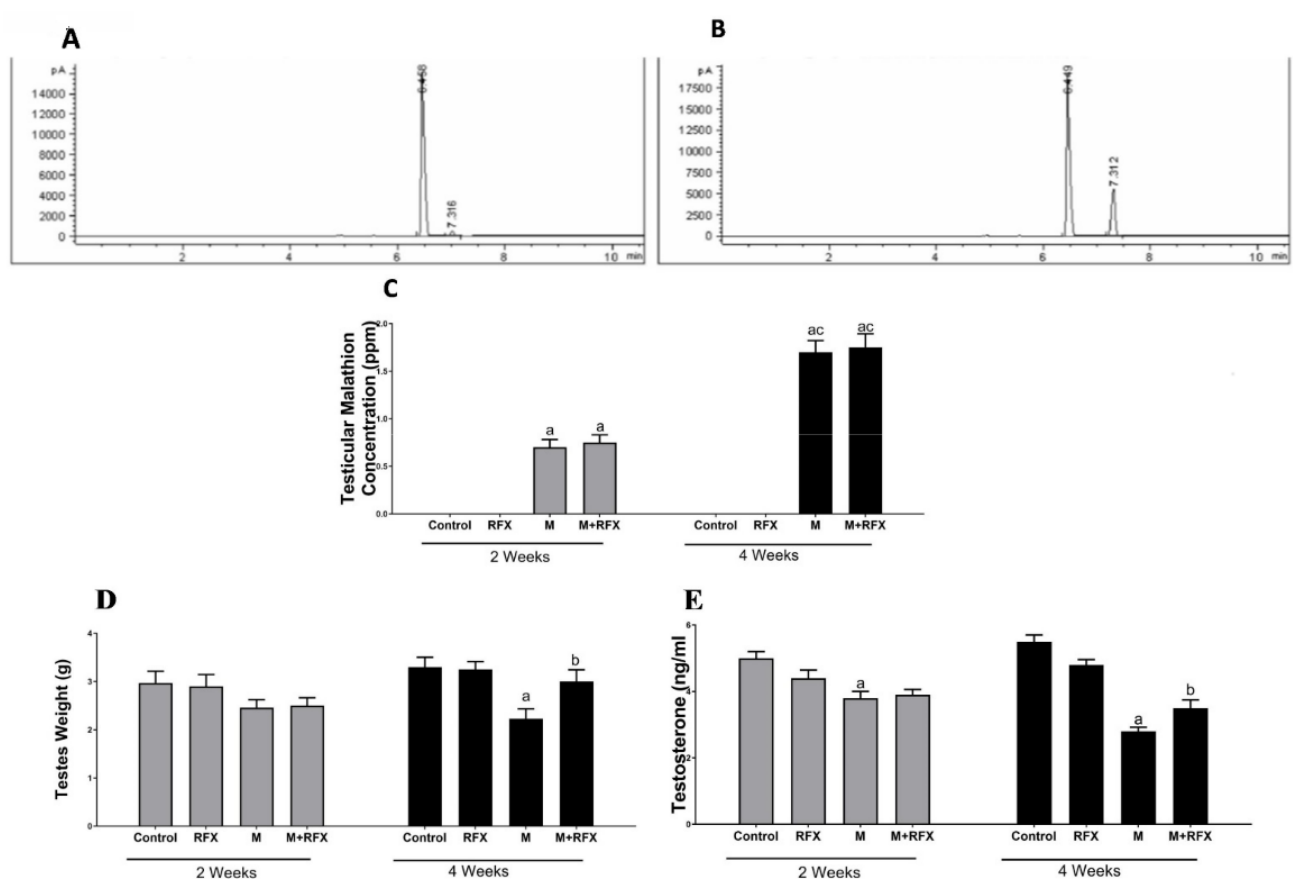
Figure 1. Testicular malathion concentration and the effects of RFX administration on testes weights and testosterone serum levels in rats. ( A ): Representative chromatogram of malathion concentration in testicular tissues after 2 weeks. ( B ): Representative chromatogram of malathion concentration in testicular tissues after 4 weeks. ( C ): Representative bars of testicular malathion concentration (ppm) after 2 and 4 weeks in different groups. ( D ): Testes weight (g) after 2 and 4 weeks in different groups. ( E ): Testosterone levels (ng/mL) after 2 and 4 weeks. Data are presented as the means ± SEM. a, significant ( p < 0.05) versus control; b, significant ( p < 0.05) versus the malathion group; c, significant ( p < 0.05) versus the two weeks group; data were analyzed with one-way ANOVA followed by Bon-